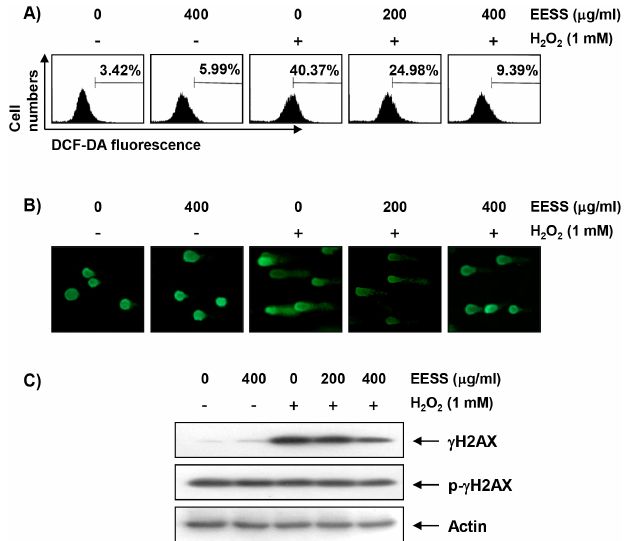
Figure 2. Protection of H 2 O 2 -induced ROS generation and DNA damage by EESS in SW1353 chondrocytes. ( A ) Cells were pretreated with the indicated concentrations of EESS for 1 h, and then stimulated with or without 1 mM H 2 O 2 for 1 h. The cells were incubated at 37 °C in the dark for 20 min with culture medium containing 10 μ M DCF-DA to monitor ROS production. The degree of ROS production was measured by flow cytometer. The data are the means of the two different experiments; ( B , C ) Cells were pretreated with EESS for 1 h, and cultured in the presence or absence of H 2 O 2 for 24 h. ( B ) To detect cellular DNA damage, the comet assay was performed, and representative photographs of the comets were taken by fluorescence microscopy (original magnification, 200×); ( C ) The cells were lysed, and then equal amounts of cell lysates were separated on SDS-polyacrylamide gels, and transferred to membranes. The membranes were probed with specific antibodies against γ H2AX and p- γ H2AX, and the proteins were visualized using an ECL detection system. Actin was used as an internal control.